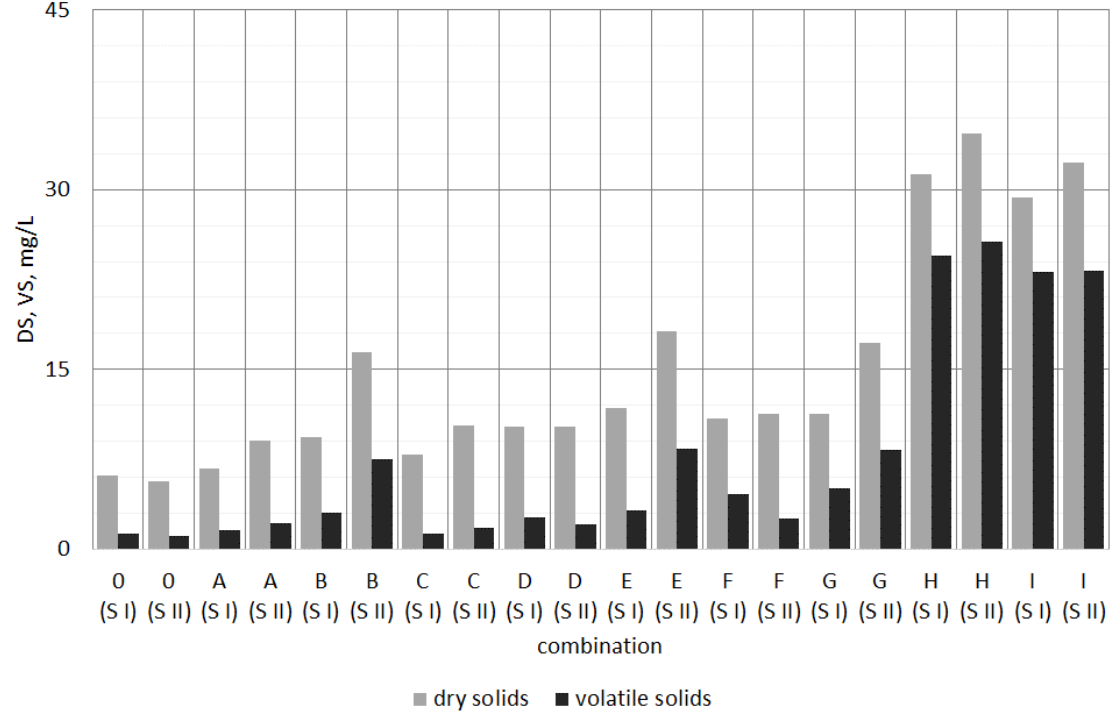
Figure 21. Dry solids and volatile solids in samples after 12 days of the process.